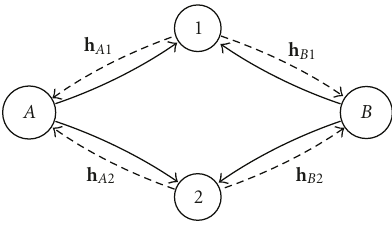
Figure 1: Model of two-way two-relay network. The labels of the arrows indicate the corresponding link